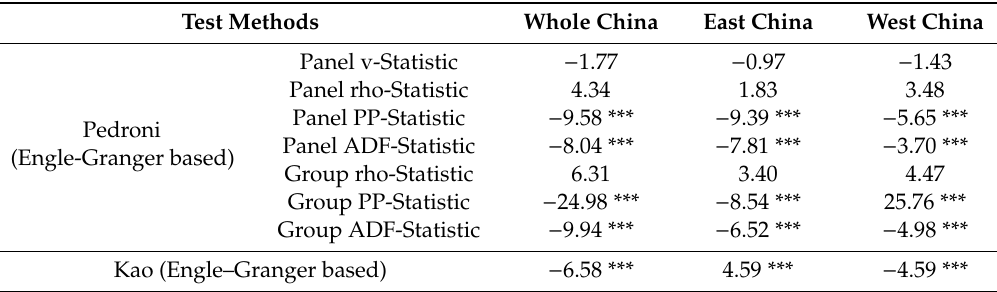
Table 4. Results of panel cointegration